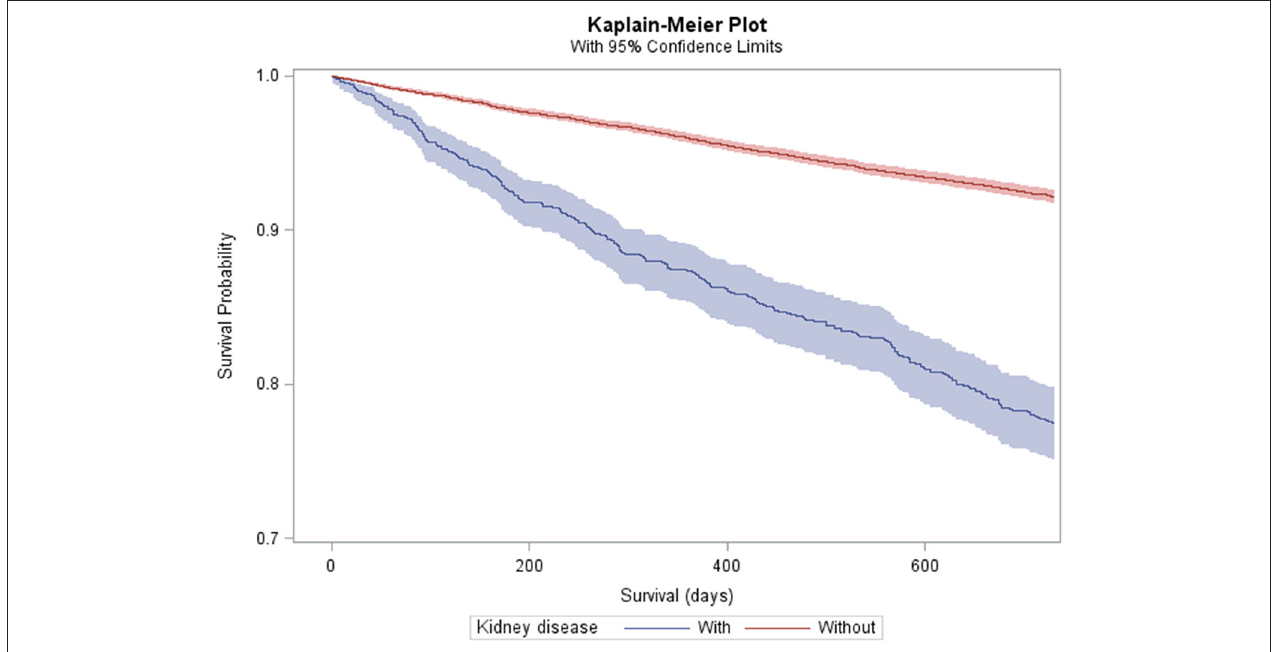
FIGURE 1 | Kaplan–Meier plot and 95% confidence limits (shaded area) of mortality among adults with cerebral palsy with ( n = 1,215) and without ( n = 15,513) kidney disease.